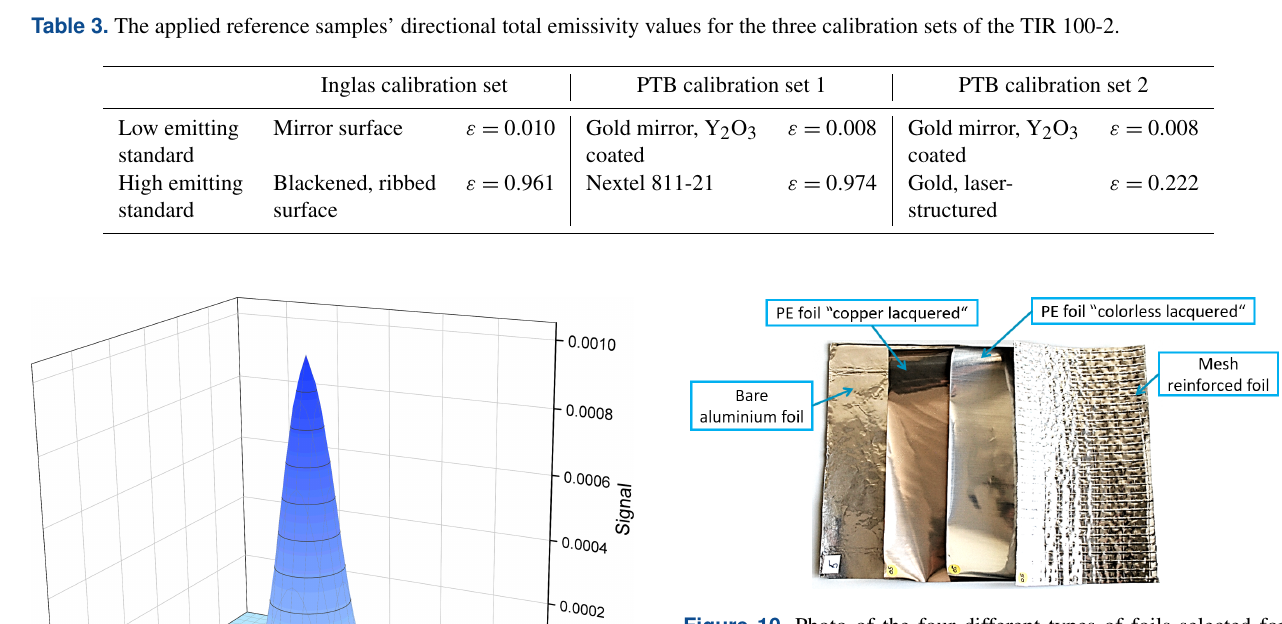
Figure 10. Photo of the four different types of foils selected for emissivity